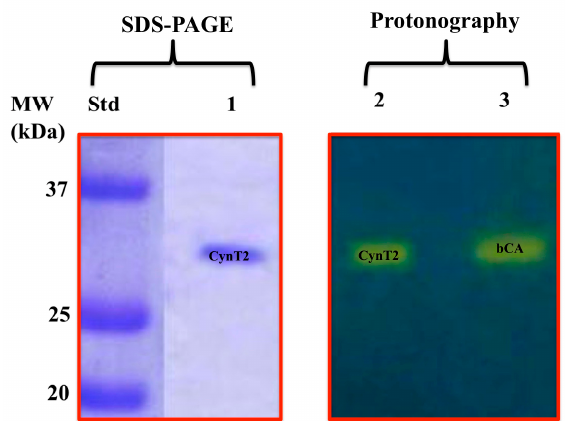
Figure 1. Analysis of the heterologous protein expression on the Coomassie Blue stained gel (SDS–PAGE) and Bromothymol Blue stained gel (Protonography). The purified recombinant CynT2 was eluted from the affinity resin by adding 250 mM imidazole. The yellow band on the protonogram (right of the figure) corresponds to the enzyme activity responsible for the drop of pH from 8.2 to the transition point of the dye in the control buffer. Lane STD, molecular markers (form bottom to the top: 20, 25, and 37 kDa); Lane STD, Molecular markers; Lane 1, purified CynT2; Lane 2, purified CynT2 subjected to protonography; Lane 3, commercial bovine CA (bCA) used as a positive control in the protonography.